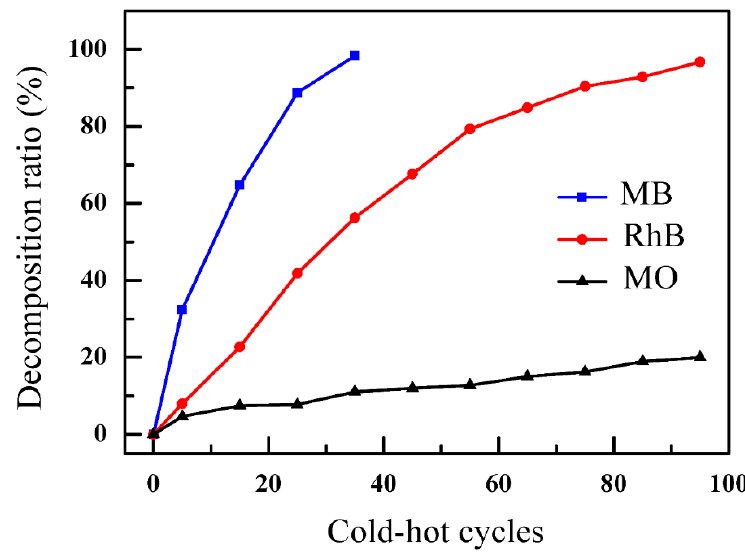
Figure 9. The pyro-catalytic dye decomposition ratios for different dye solutions.